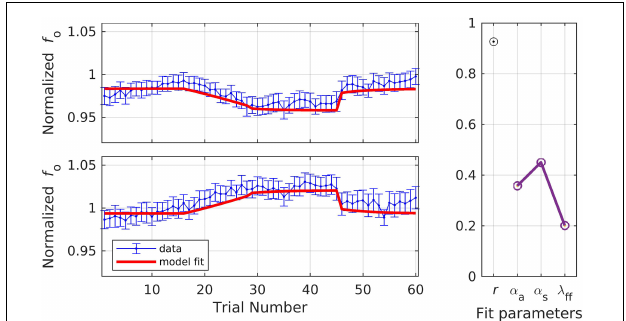
FIGURE 8 | Simulation 6: model fits of a dataset with perturbations applied to fundamental frequency in both shift-up and down directions [normalized by an unshifted control condition; data from Heller Murray (2019)]. Shift-up and down data are fit simultaneously. Measurement of fundamental frequency was taken late in the trial (200–1500 ms after voicing onset). (Left) Mean and standard error of experimental data in blue; model fit in red. (Right) Fit quality and optimized parameter values ( r = correlation coefficient; α A = auditory feedback control gain, α s = somatosensory feedback control gain, and λ FF = learning rate).